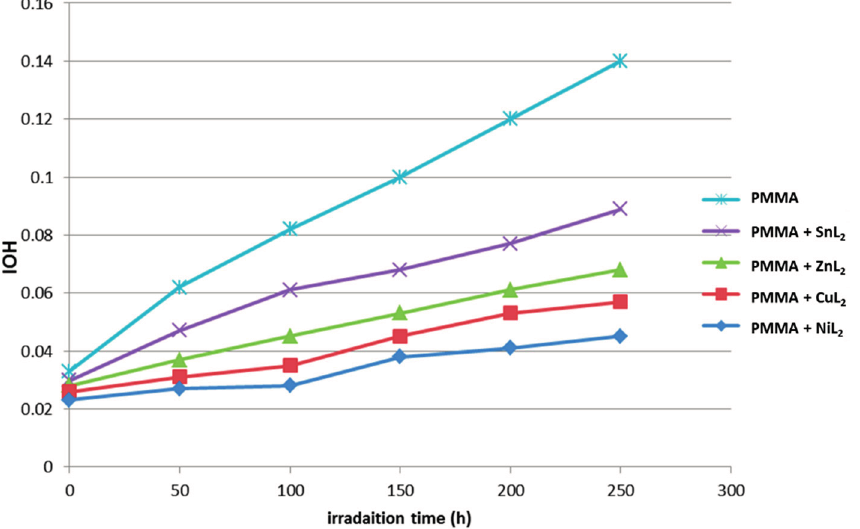
Figure 9. The relationship between the hydroxyl index and irradiation time for PMMA films (40- μ m thickness) with different additives (0.5% by